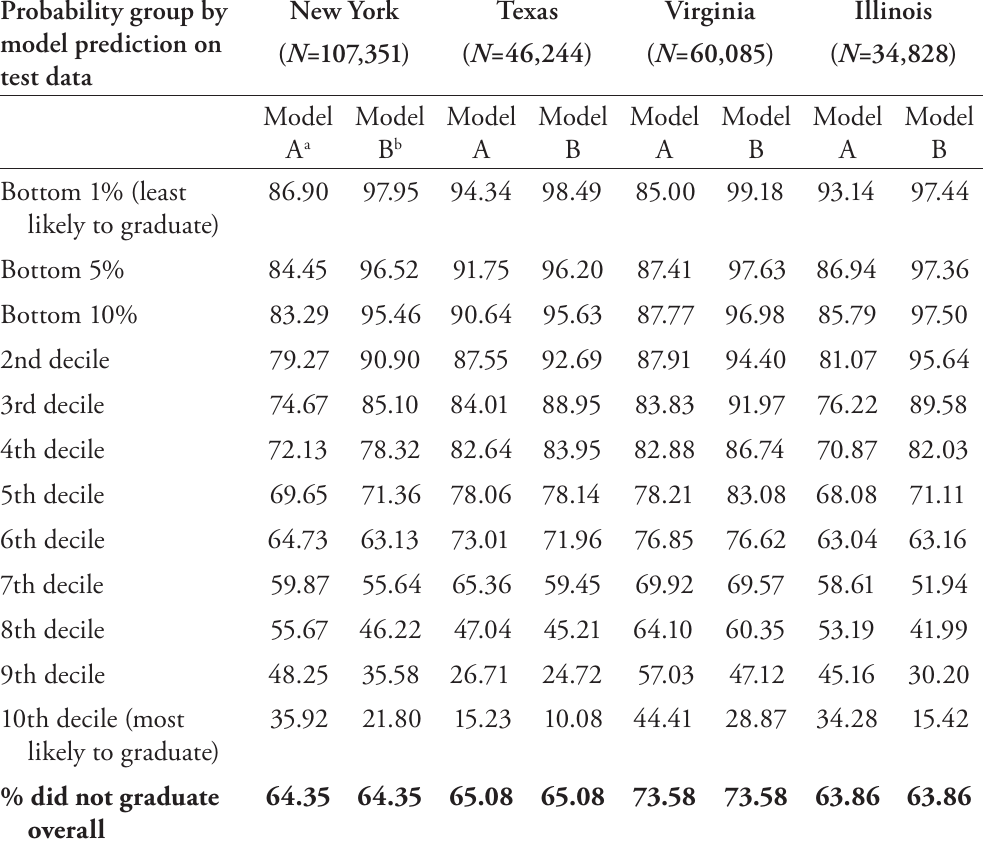
Table 2. AA Students’ Predicted Probability Distribution of Graduation by Actual % of Students that Did Not Graduate Probability group by model prediction on test data